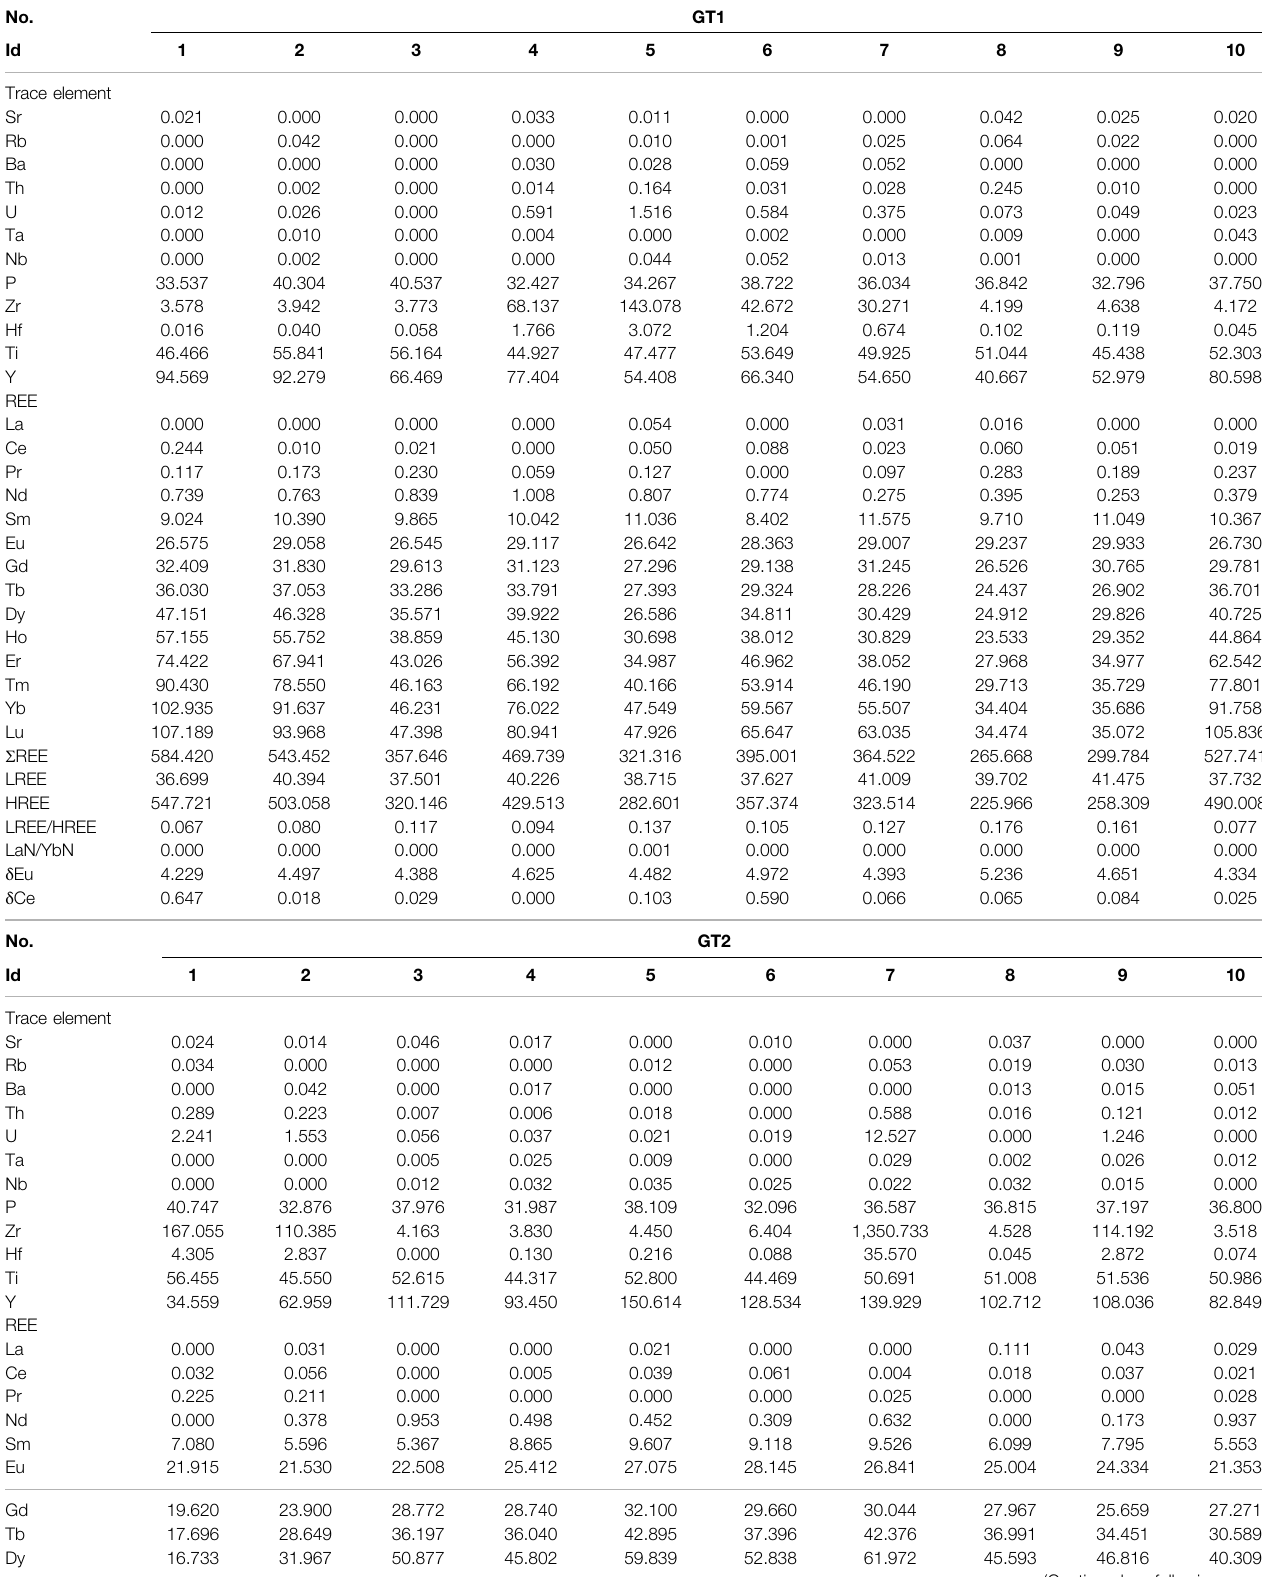
TABLE 5 | Representative LA-ICP-MS data (ppm) of garnets from the Tiemurt deposit. No.